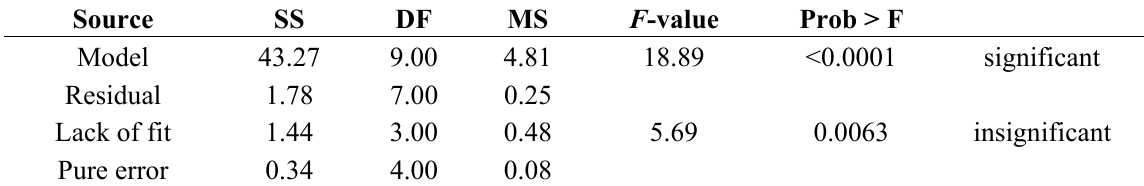
Table 2. Analysis of variance for the fitted quadratic polynomial model.